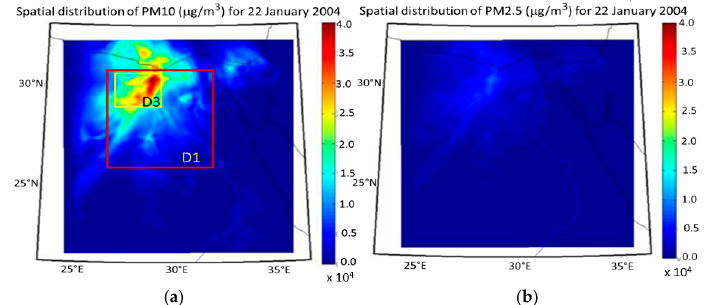
Figure 4. Spatial distribution of the PM 10 ( a ) and PM 2.5 ( b ) during the dust storm of January 2004 from DS1 with coeff. 2.0. Domains D1 and D3 are shown. The color bar represents the particle density ( μ g/m 3 ) multiplied by 10 4 .